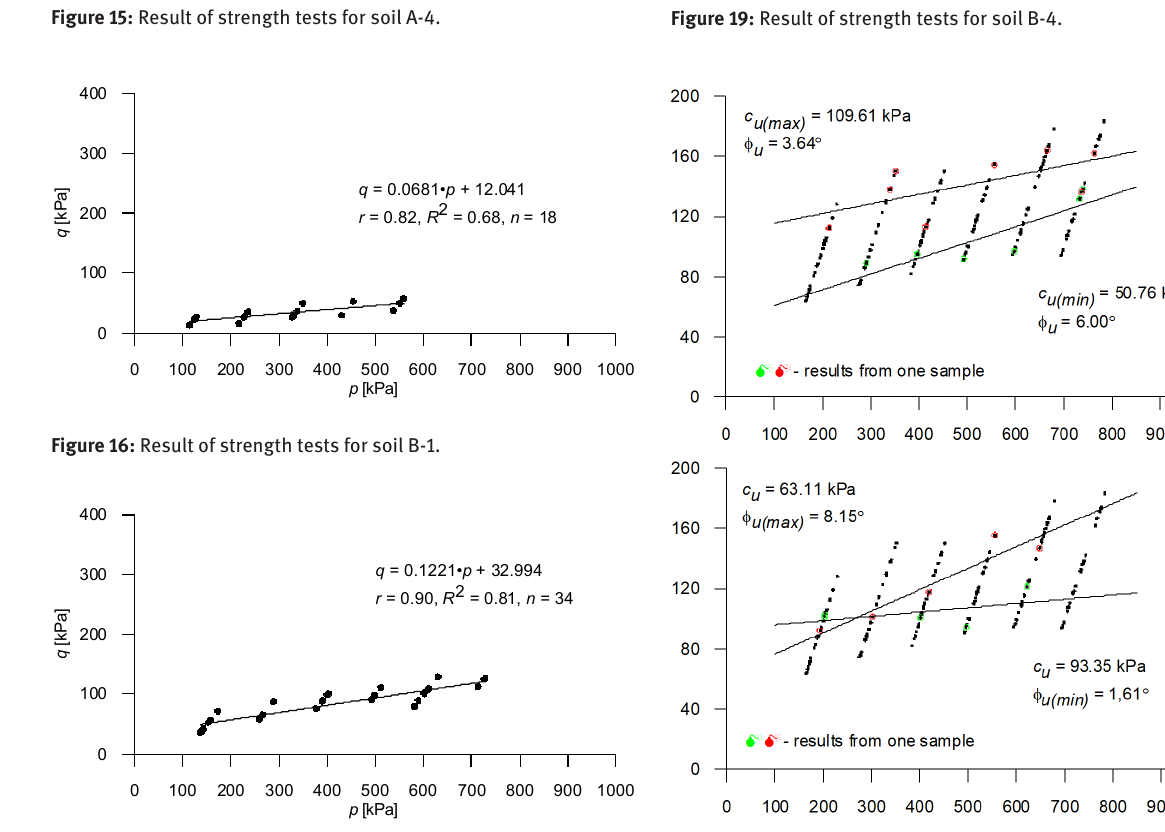
Figure 20: The disparity of results of cohesion and angle of internal friction for soil